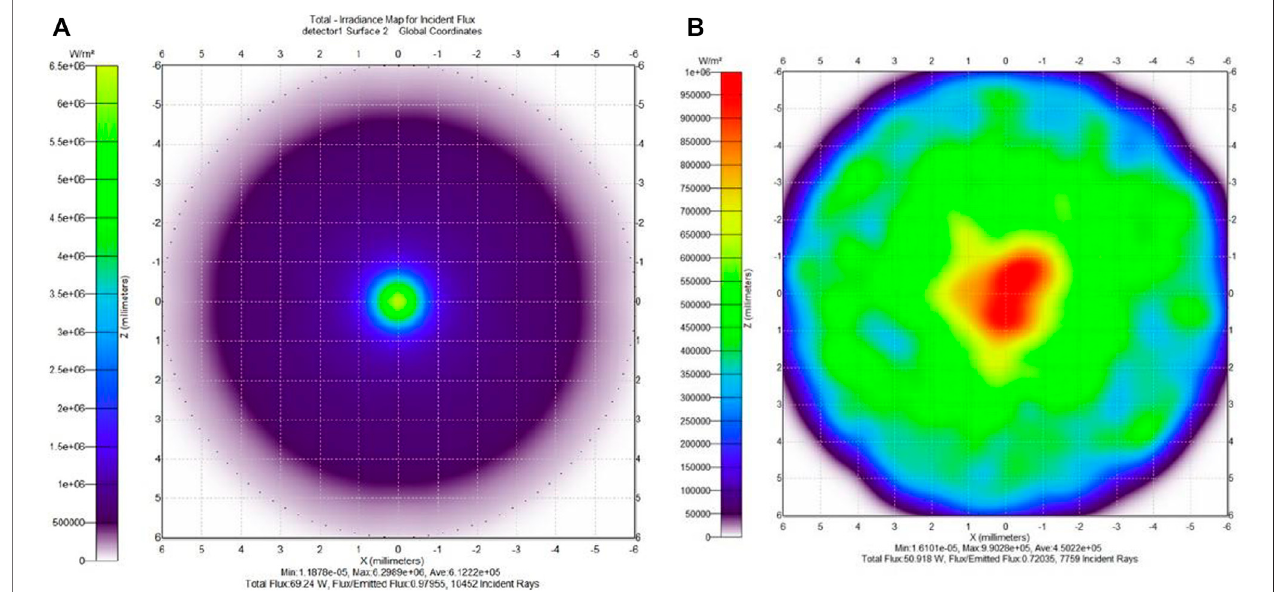
FIGURE 7 | Irradiance map for fl ux absorbed by the CM-1 under different ray source types: (A) uniform ray and (B) solar ray.